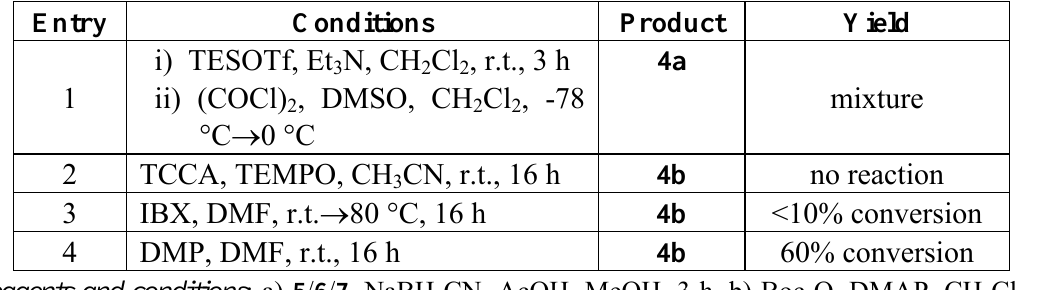
Table 1. Conditions for selective oxidation of primary